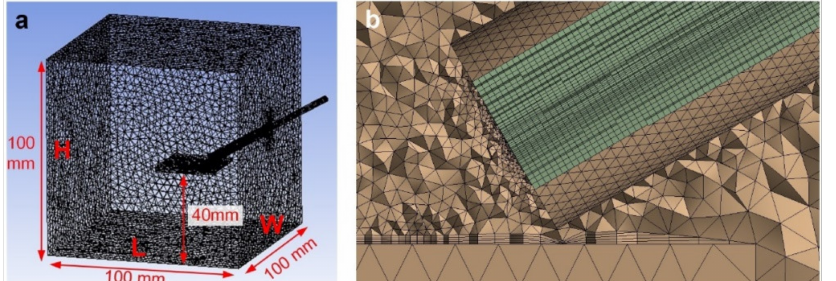
Figure 3. ( a ) Three-dimensional geometry and ( b ) mesh details of the flow domain at the impingement angle of 30 ◦